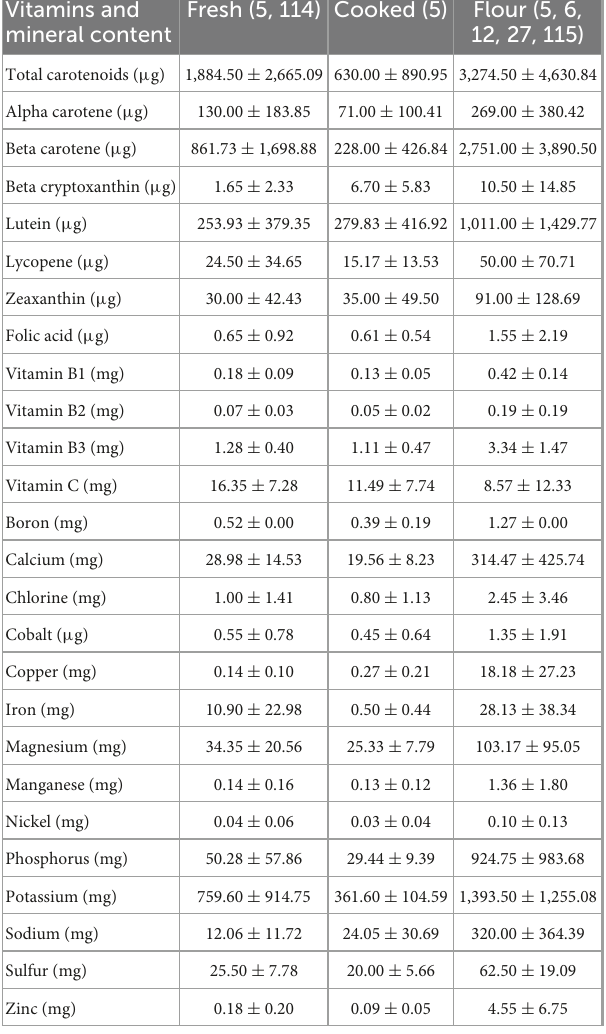
TABLE 2 Minimum and maximum carotenoid and vitamin content for breadfruit ( Artocarpus altilis and hybrids) per 100 g sample. Vitamins and Fresh (5, 114) Cooked mineral content